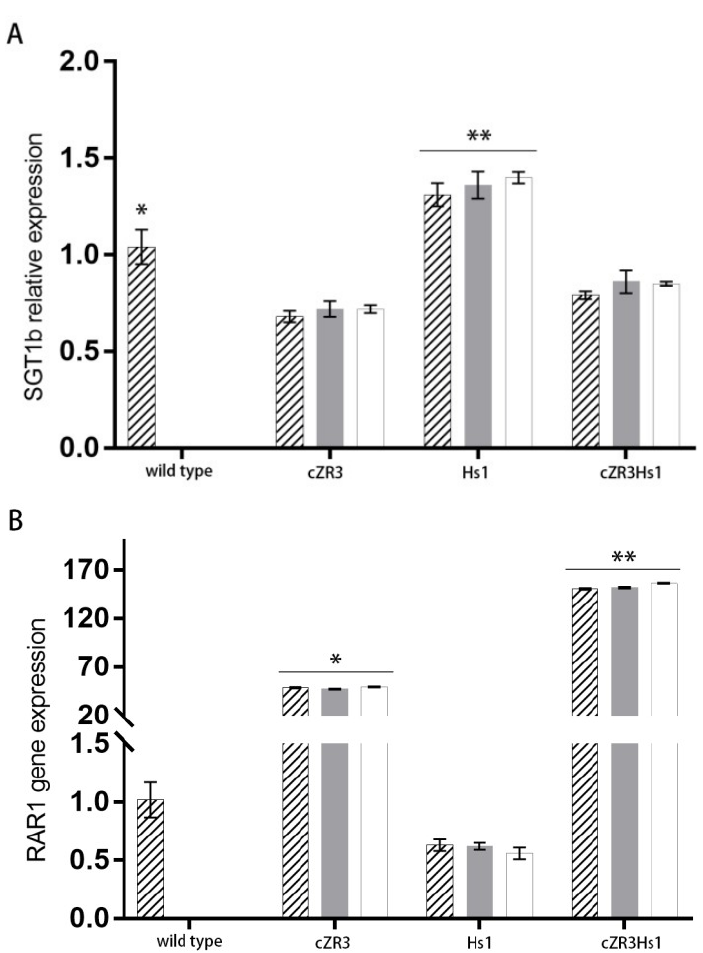
Figure 8. The relative expression of SGT1b ( A ) and RAR1 ( B ) gene among wild type, cZR3 and Hs1 pro-1 , and cZR3Hs1 pro-1 pyramiding plants by qRT‐PCR. The diagonal stripes, grey, white rectangles represent independent wildtype plants and transgenic lines. The averages ± standard errors from three separate replicates are shown. Significant difference is indicated by different symbols (* and **), as determined by Duncan’s test.